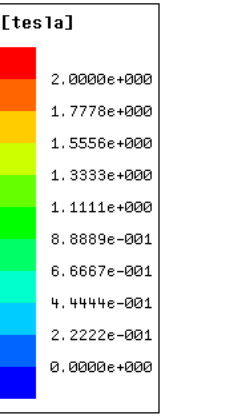
Figure 21. No-load flux density distribution of the claw at maximum linked flux.